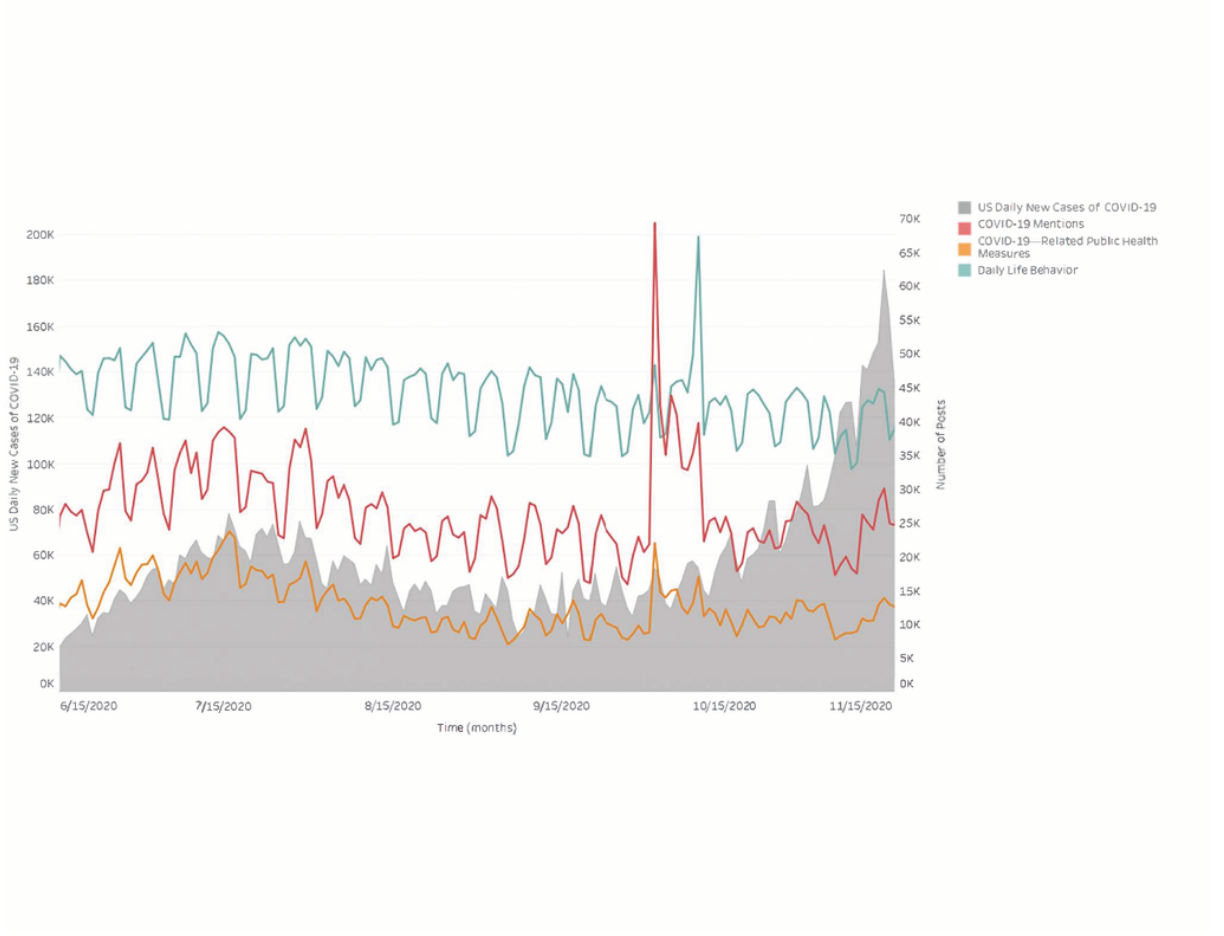
Figure 1. Online social discussion categories versus US daily new COVID-19 cases (June 15 to November 15,